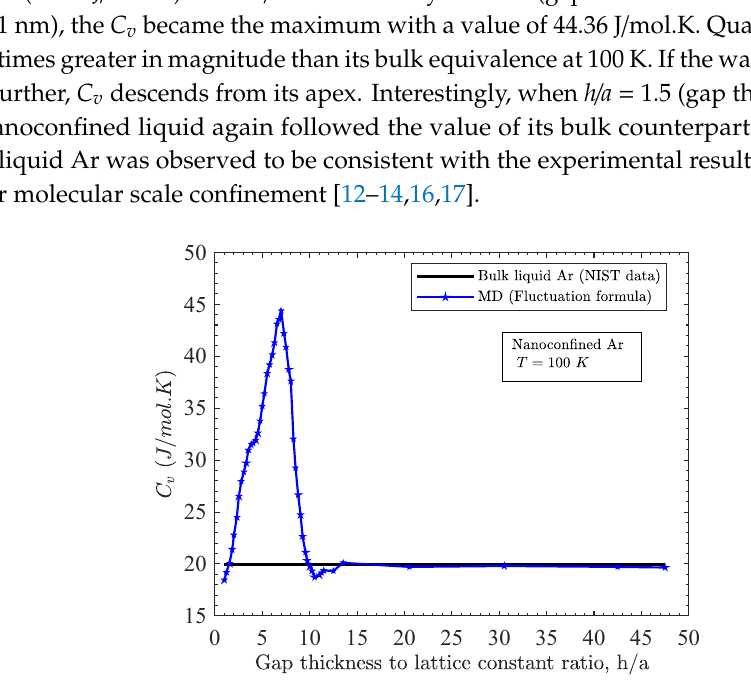
Figure 2. Variation of heat capacity of nanoconfined liquid at different gap thickness (T = 100 K).